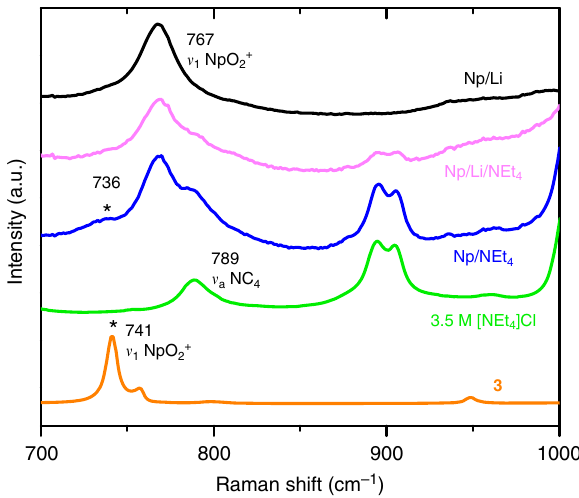
Fig. 2 Comparison of Np V Raman spectra. Raman spectra of 0.12 M Np V dissolved in 3.5 M LiCl (Np/Li, black line), 1.75 M LiCl/1.75 M NEt 4 Cl (Np/ Li/NEt 4 , magenta line), and 3.5 M NEt 4 Cl (Np/NEt 4 , blue line); Raman spectra of a 3.5 M NEt 4 Cl solution (green line) and of the crystalline product [NMe 4 ]Cl[NpO 2 Cl(H 2 O) 4 ] ( 3 ) (orange line). The intensities of all spectra are scaled to facilitate